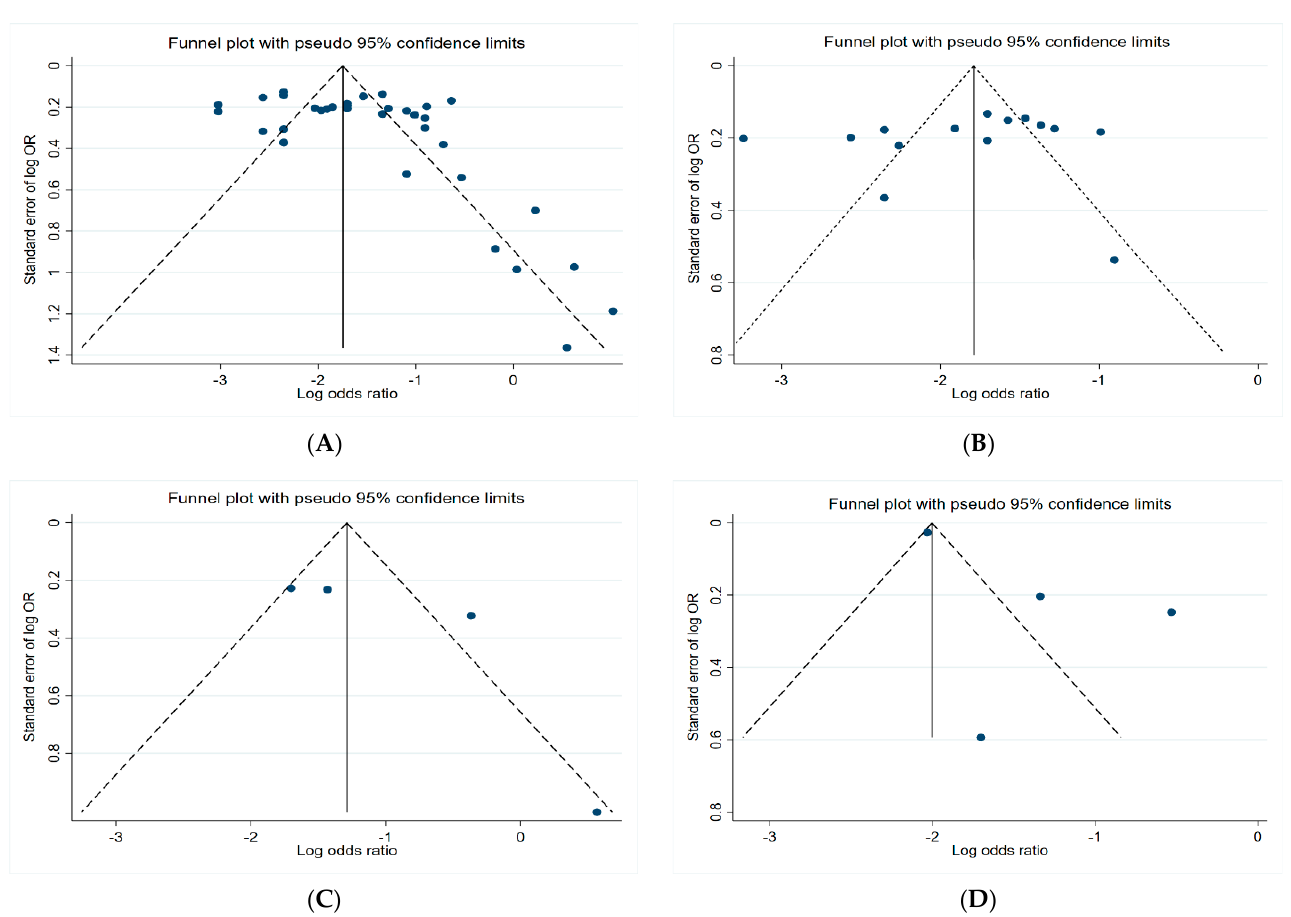
Figure 6. Funnel plots. ( A ) Insecticides; ( B ) herbicides; ( C ) fungicides; ( D ) non-specific pesticides.